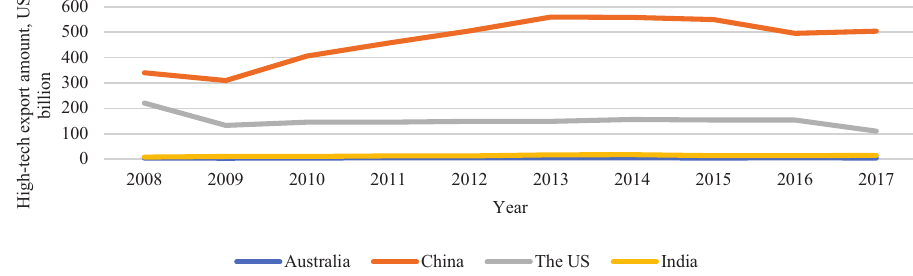
Figure 2. High-tech export amount in Australia, China, The US and India from 2008 to 2017, US$ in billion